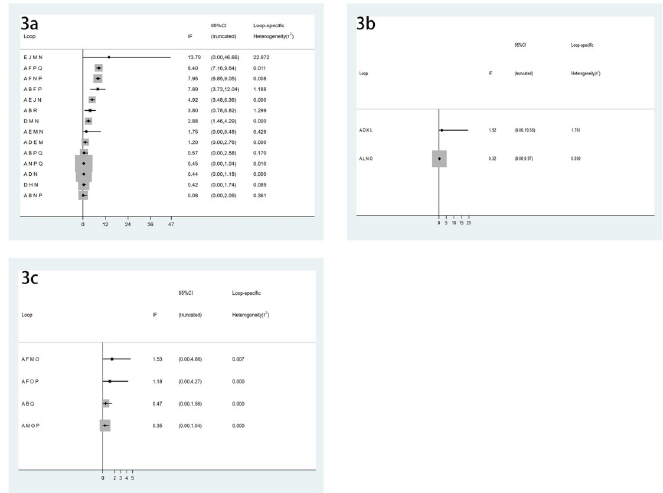
Fig 3. Loop-specific heterogeneity diagram. (3a) Mean percentage change of BMD of LS from baseline, (3b) Mean percentage change of BMD of TH from baseline, (3c) Serious adverse events.